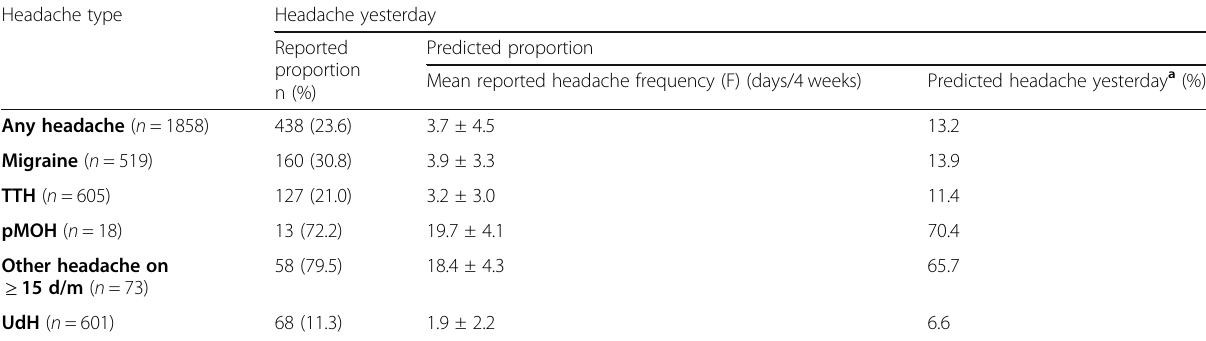
Table 5 Proportions reporting headache yesterday, and predicted proportions a , overall and by headache type ( N = 2505) Headache